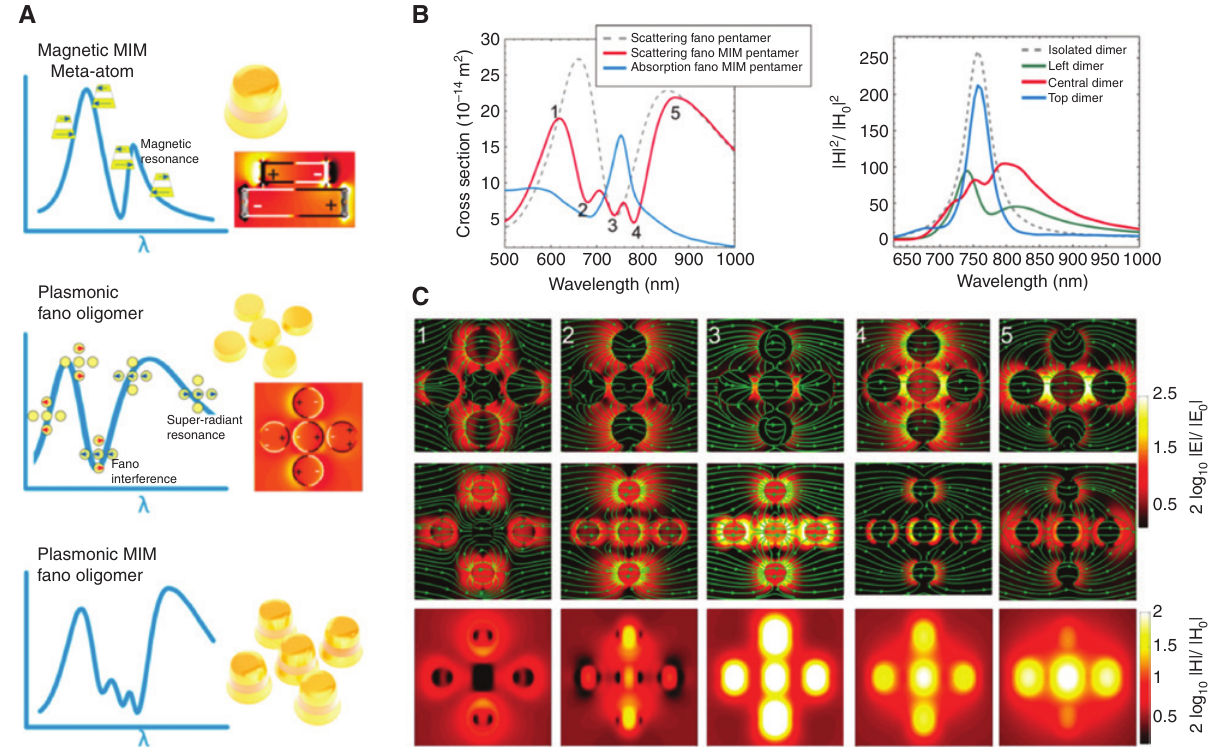
Figure 5: Magnetic resonance broadening in the optical regime. (A) The scattering properties of a single vertical MIM dimer (top), plasmonic oligomer (centre) and MIM oligomer (bottom). The properties of the first two architectures are combined in the latter system that supports multiple subradiant modes, thus generating a quasi-broadband magnetic response at visible frequencies. (B) Left, simulated spectral response of a MIM pentamer (solid lines) and a standard gold pentamer (dashed line). Right, calculated magnetic field at the center of the dielectric spacer for the different vertical dimers in the MIM pentamer (solid lines). As a comparison, the magnetic enhancement for an isolated dimer is also shown (dashed line). (C) Electric field intensity and field lines at the center of the bottom disk (first row), top disk (second row) and magnetic field in the dielectric spacer at the wavelengths indicated by 1–5 in (B). Adapted with permission from Verre R, Yang ZJ, Shegai T, Käll M. Optical magnetism and plasmonic Fano resonances in metal–insulator–metal oligomers. Nano Lett 2015;15:1952–8 (Ref. [48]). Copyright 2015 American Chemical